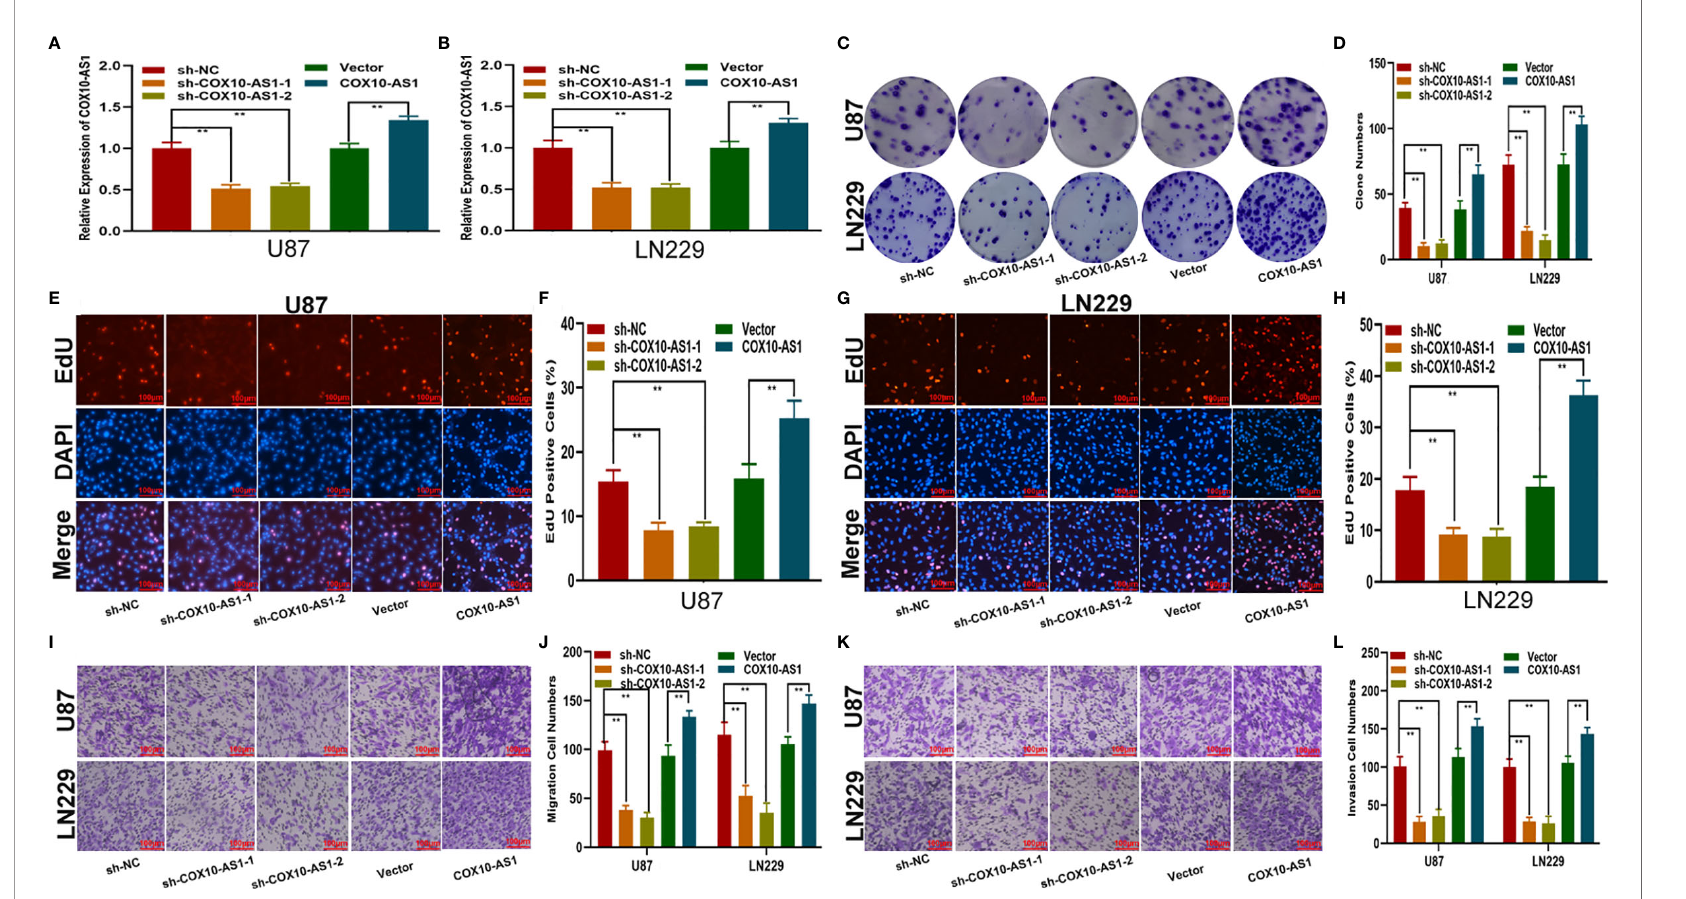
FIGURE 2 | COX10-AS1 promotes glioma proliferation, migration and invasion in vitro. (A, B) Relative expression of COX10-AS1 in U87 and LN229 cells transfected with sh-COX10-AS1 (including sh-COX10-AS1- 1, sh-COX10-AS1-2), COX10-AS1 plasmid or the corresponding negative control, as measured by qRT-PCR. (C, D) The proliferation of U87 and LN229 cells transfected with sh-COX10-AS1, COX10-AS1 plasmid or the corresponding negative control, as measured by clone formation assays. (E – H) The proliferation of U87 and LN229 cells transfected with sh-COX10-AS1, COX10-AS1 plasmid or the corresponding negative control, as measured by EdU assays. (I, J) The migration of U87 and LN229 cells transfected with sh-COX10-AS1, COX10-AS1 plasmid or the corresponding negative control, as measured by Transwell assays. (K, L) The invasion of U87 and LN229 cells transfected with sh-COX10-AS1, COX10-AS1 plasmid or the corresponding negative control, as measured by Transwell assays. **P <